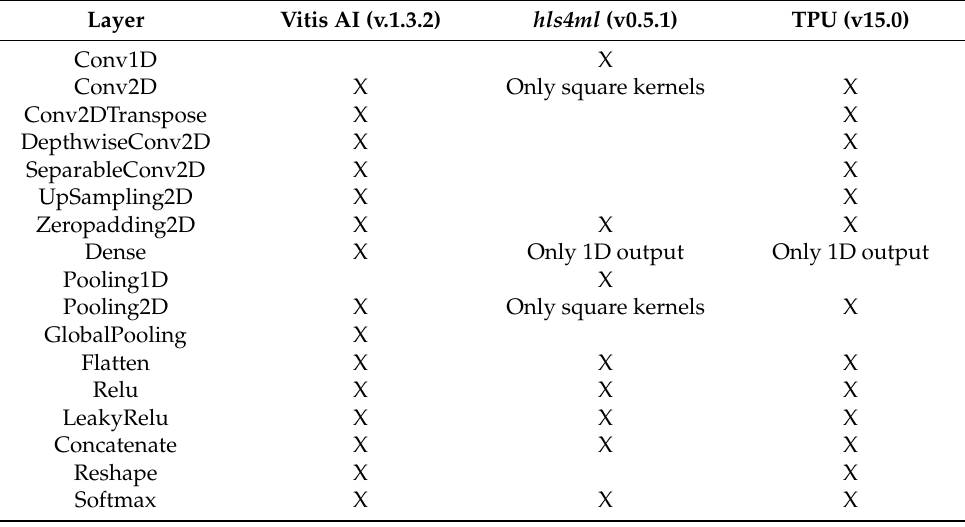
Table 16. Summary of supported layers/operations across the tool